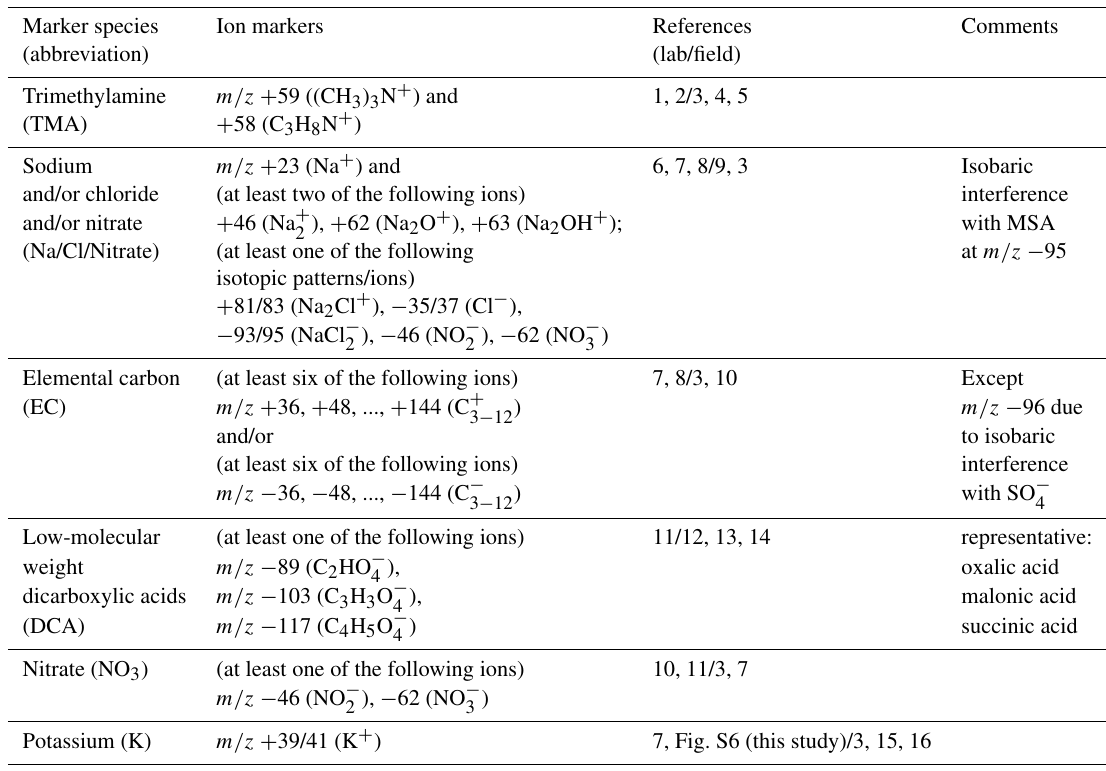
Table 1. Particle classification by marker species and associated ion markers applied in this study. References from laboratory and field studies using single-particle mass spectrometry are indicated by numbers that are defined below. This table is partly adapted from Köllner et al.